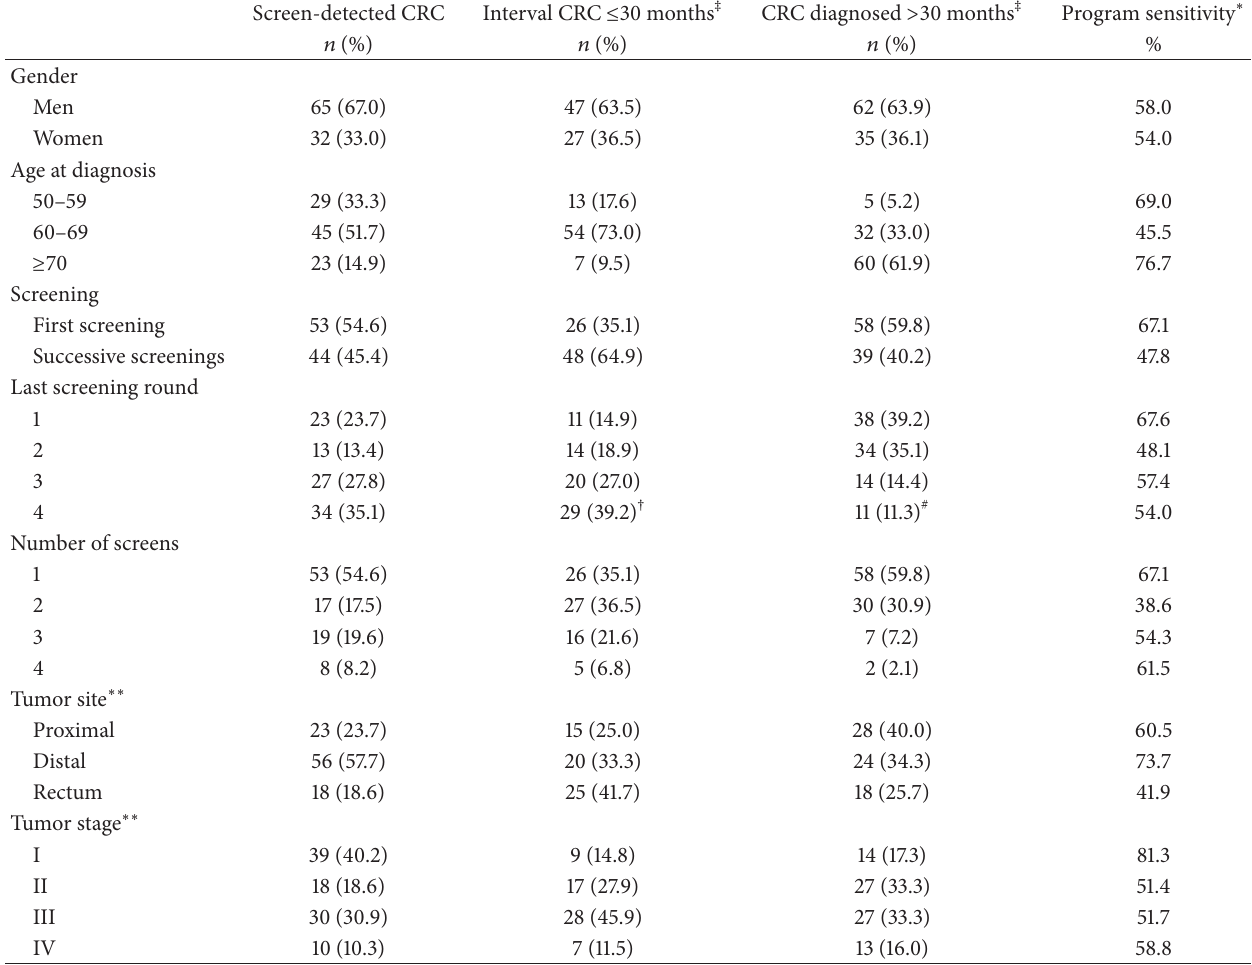
Table 3: Program sensitivity according to demographic, screening, and tumor